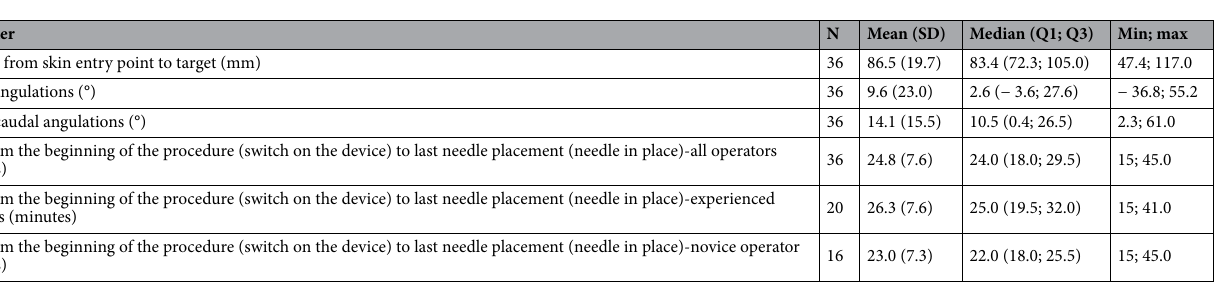
Table 1. Characteristics of percutaneous robotically-assisted needle insertions. Analyses based on last needle